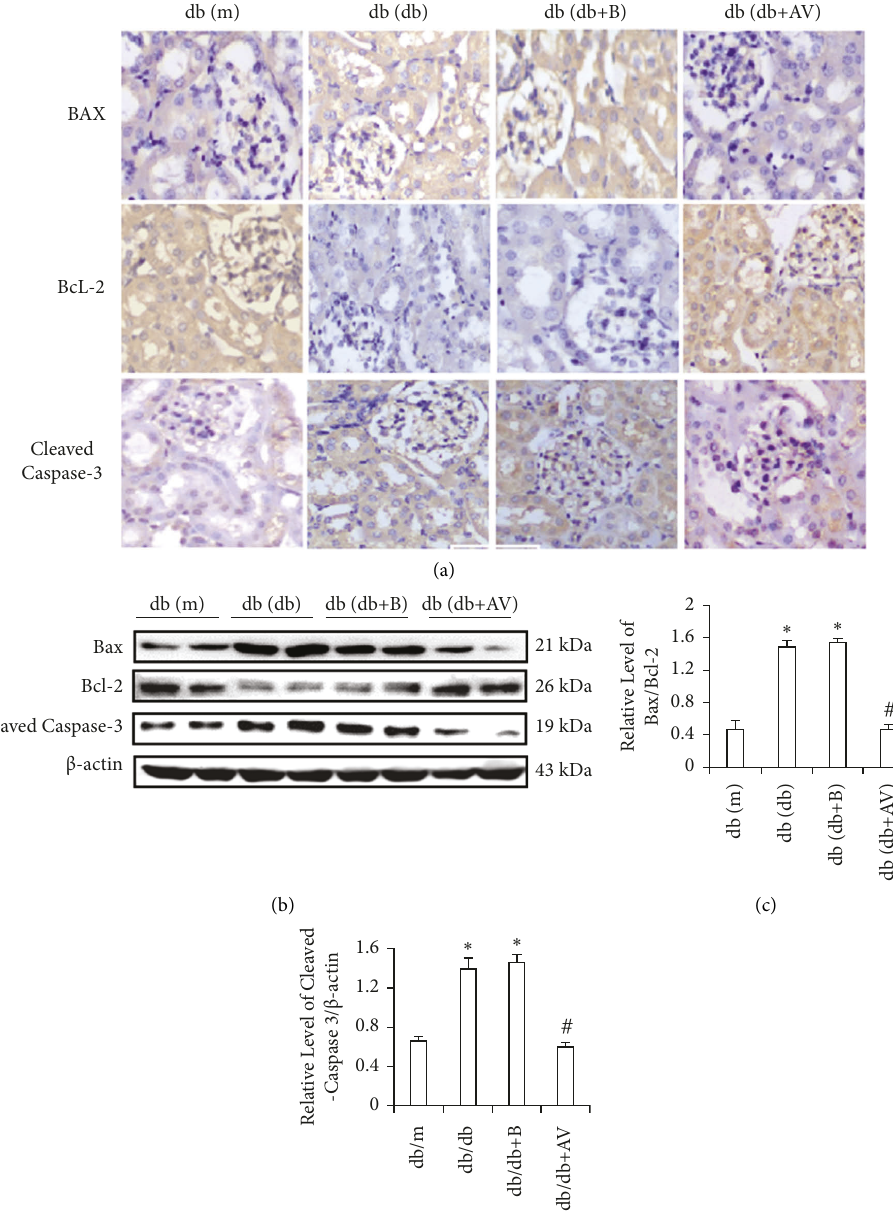
Figure 3: REDD1 deficiency attenuates apoptosis in diabetic mice. (a) The expression of Bax, Bcl-2, and Cleaved Caspase-3 was examined by immunohistochemistry (scale bar, 50 μ m). (b, c, d) The expression of Bax, Bcl-2, and Cleaved Caspase-3 was determined by western blot analysis. Values are expressed as means